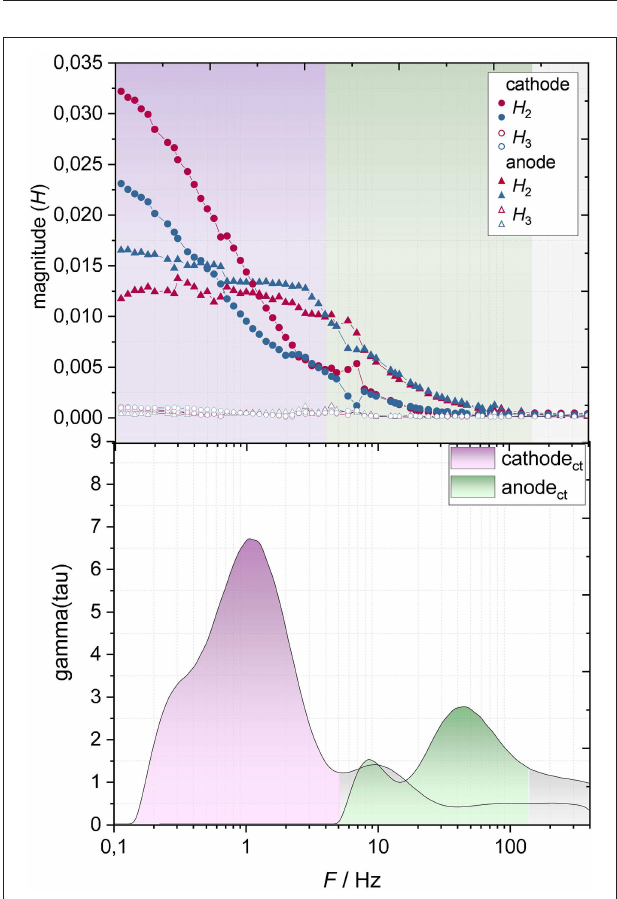
FIGURE 12 | Electrode-resolved NLEIS spectra (Top) for charge (red) and discharge (blue) direction and electrode-resolved DRT plot (Bottom) of the lithium-ion battery at a cell voltage of 3.7V at a temperature of 0 ◦